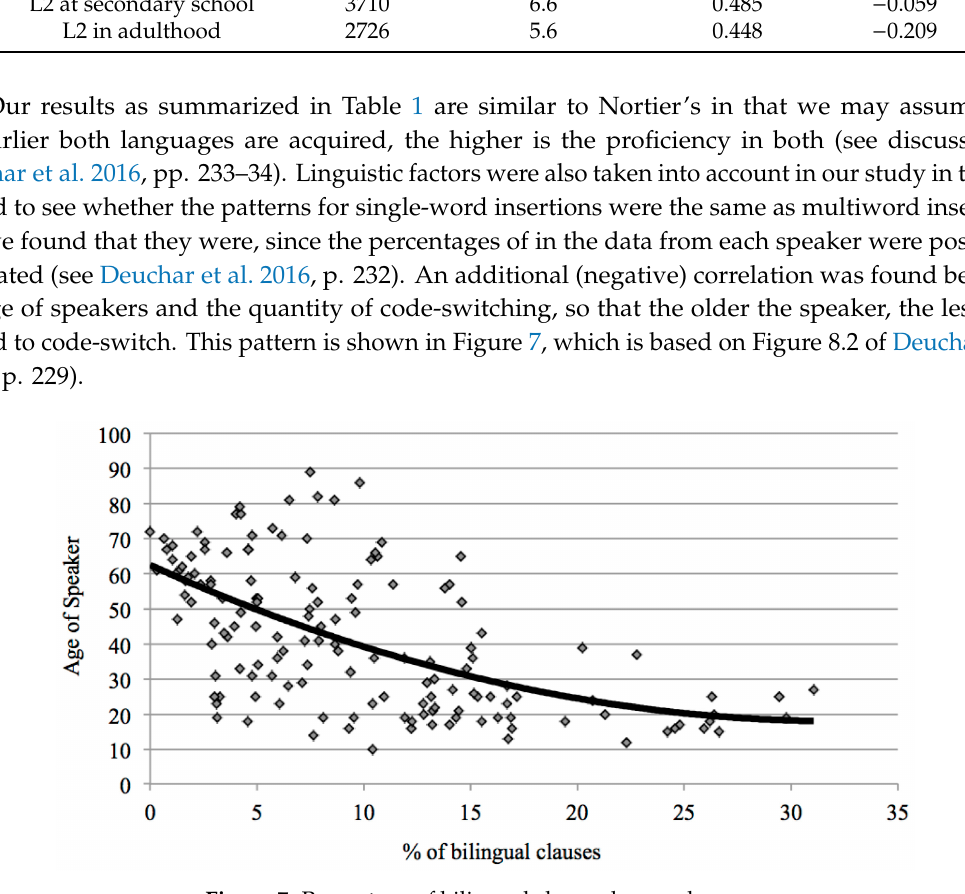
Table 1. 6 Mixed effects logistic regression predicting bilingual clauses with speaker as a random effect.